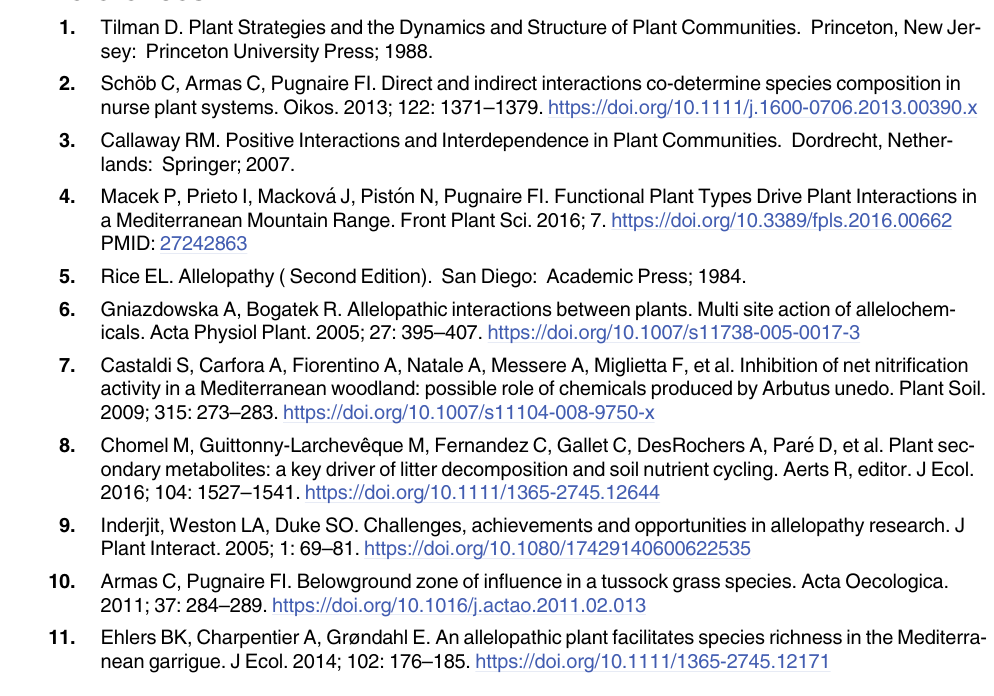
S1 Table. Initial size (cm 3 , mean ± SE) of target species juveniles transplanted by microsite. ART, A . herba-alba ; SAL, S . vermiculata ; BS, bare soil. Significant differences among microsites (ANOVA, p < 0.05) are highlighted in